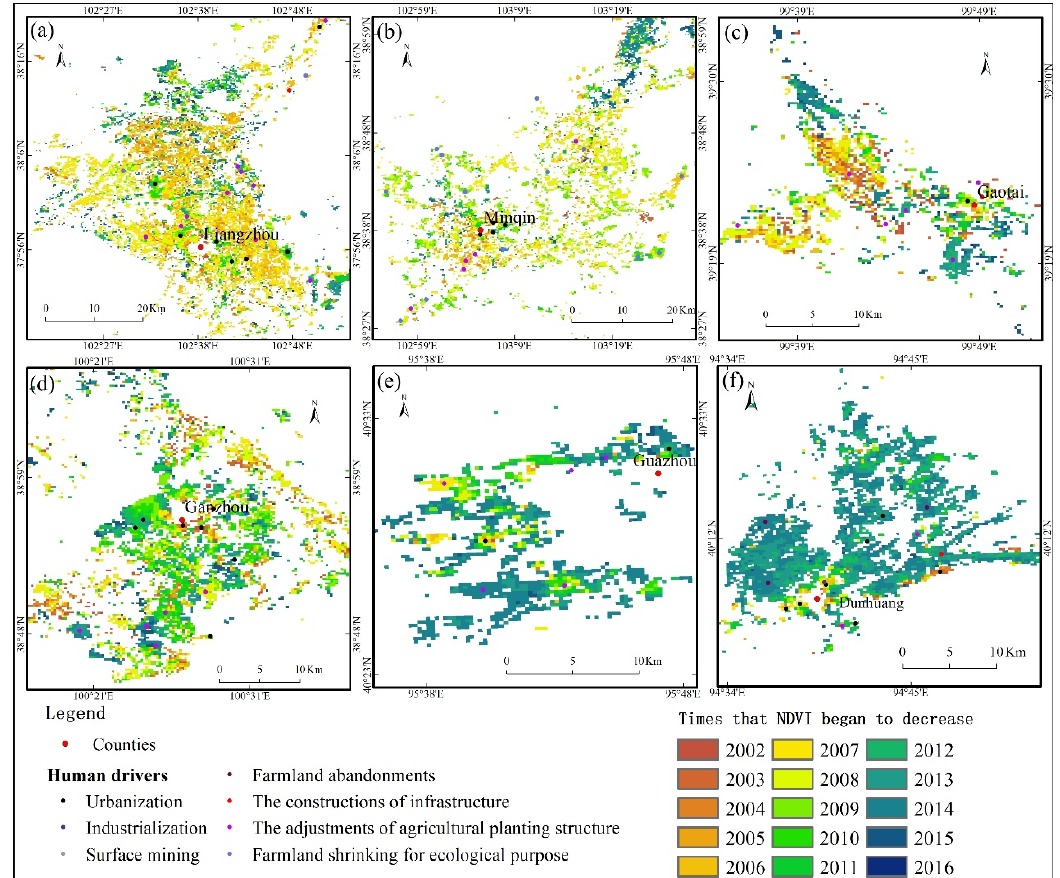
Figure 6. The time that NDVI began to decrease in the oases where decreasing trends were concentrated (as showed in Figure 4). ( a )–( f ) represent the time that NDVI began to decrease in Liangzhou ( a ), Minqin ( b ), Gaotai ( c ), Ganzhou ( d ), Guazhou ( e ), and Dunhuang ( f ), respectively. The human